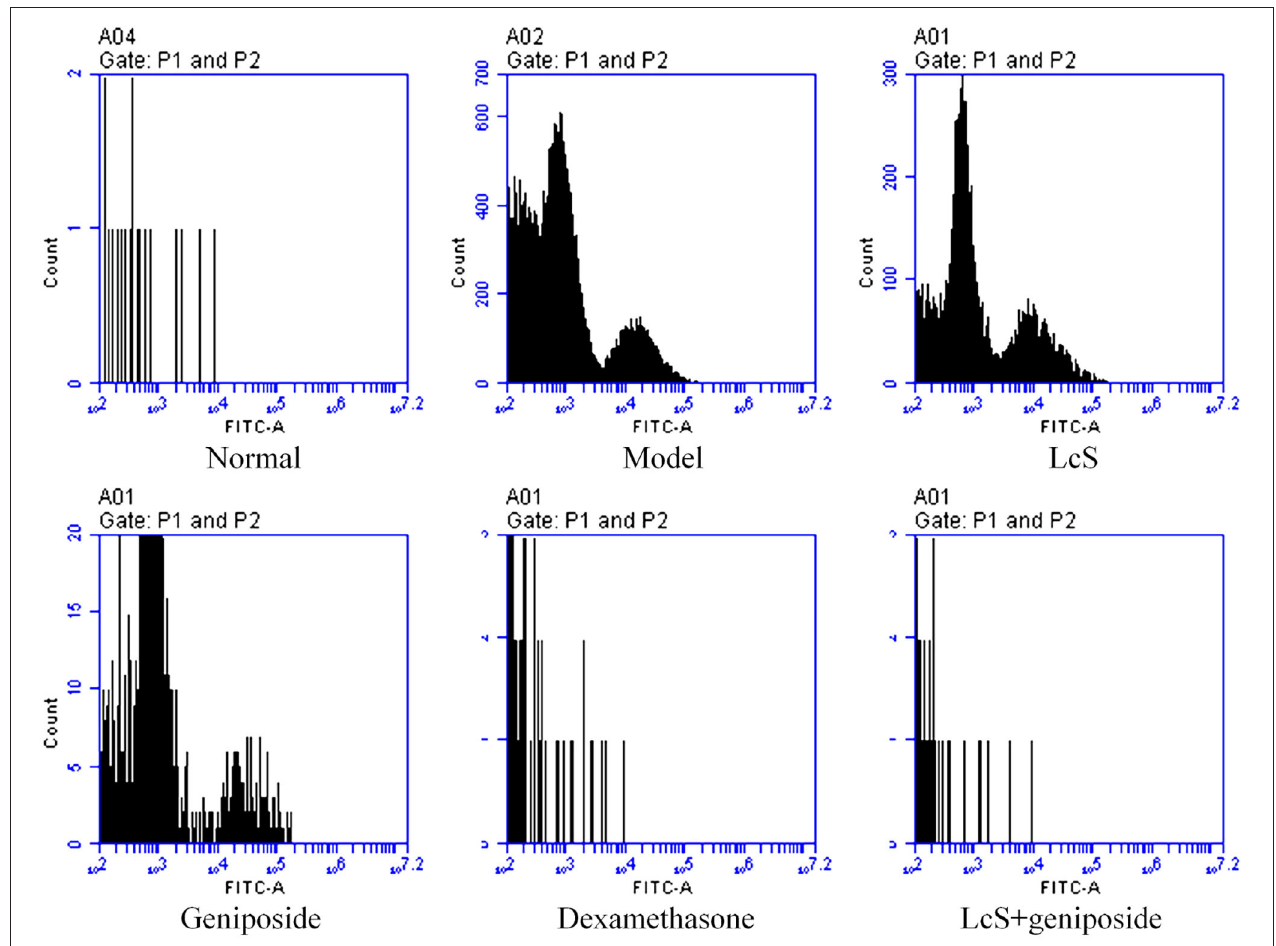
FIGURE 3 | Apoptosis of neuronal cells of septic mice on the seventh day ( n = 3). Normal: untreated mice; model: mice with induced sepsis; LcS: 5 × 10 7 CFU/kg-treated mice with sepsis; geniposide: 50 mg/kg geniposide-treated mice with sepsis; dexamethasone: 1 mg/kg dexamethasone-treated mice with sepsis; LcS + geniposide: 5 × 10 7 CFU/kg LcS and 50 mg/kg geniposide-treated mice with sepsis. a − e Mean values with different letters over the bar are significantly different ( P < 0.05) according to Tukey’s honestly significant difference test.